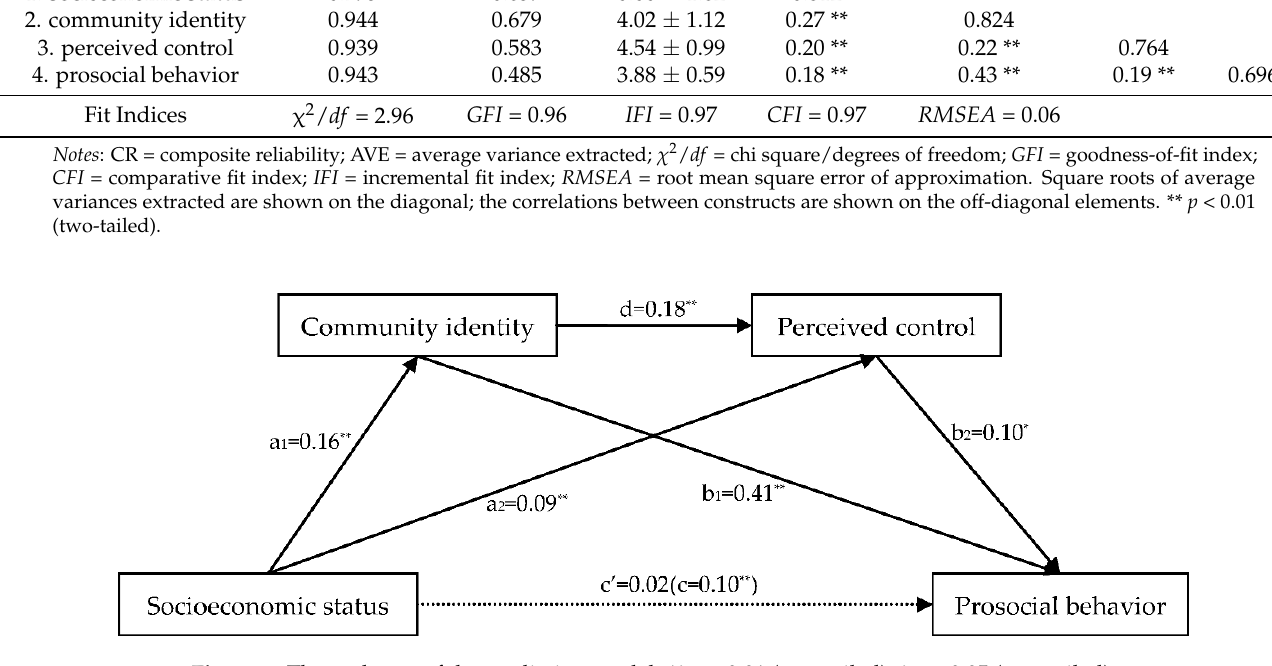
Figure 2. The pathway of the mediating model. ** p < 0.01 (two-tailed); * p < 0.05 (two-tailed).